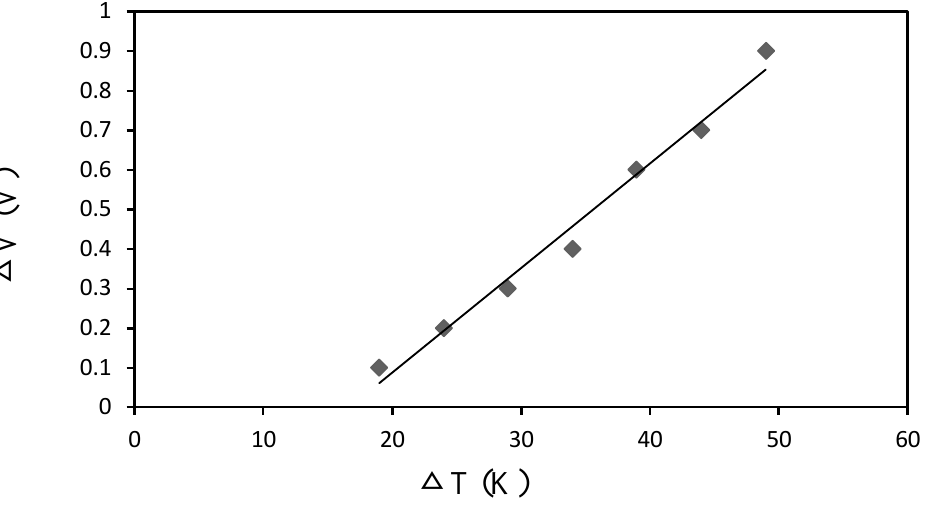
Figure 6 : The thermovoltage, ∆V, against the temperature difference,